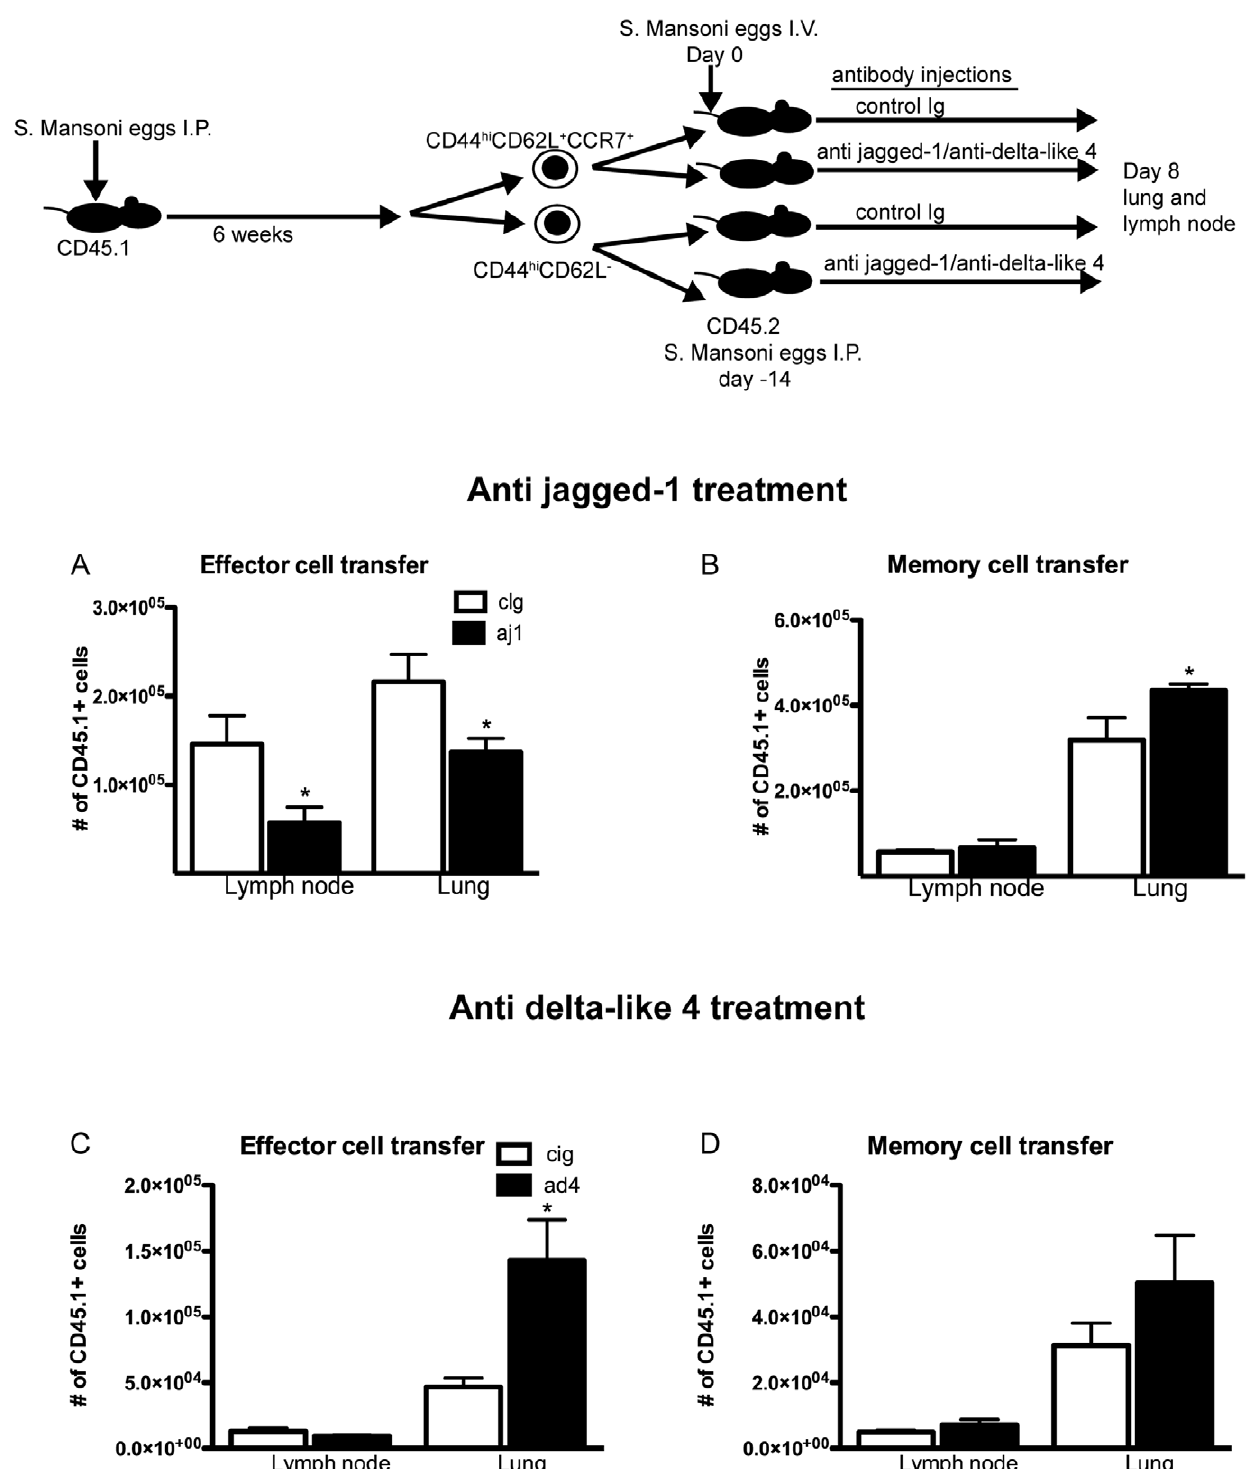
Figure 3. Memory and effector cell expansion are differentially affected by Notch ligand blockade invivo . Congenic effector or memory cells were transferred from S. mansoni sensitized donors into similarly sensitized hosts that subsequently received S. mansoni egg challenge A,B) Effector cell number was reduced in the presence of anti jagged-1 in both the lung and the lymph node, whereas the same treatment increased the proliferation of secondary effectors (derived from memory cells) in the lung. C,D) Anti delta-like 4 treatment during the same response causes a significant increase in the amount of effector cells. *p # 0.05 in all cases using an unpaired T test analysis.